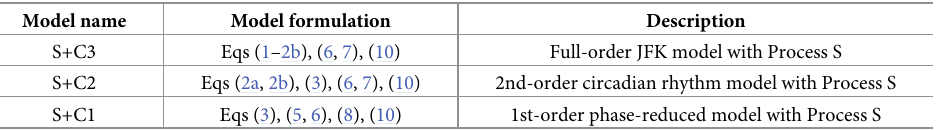
Table 2. Two-process